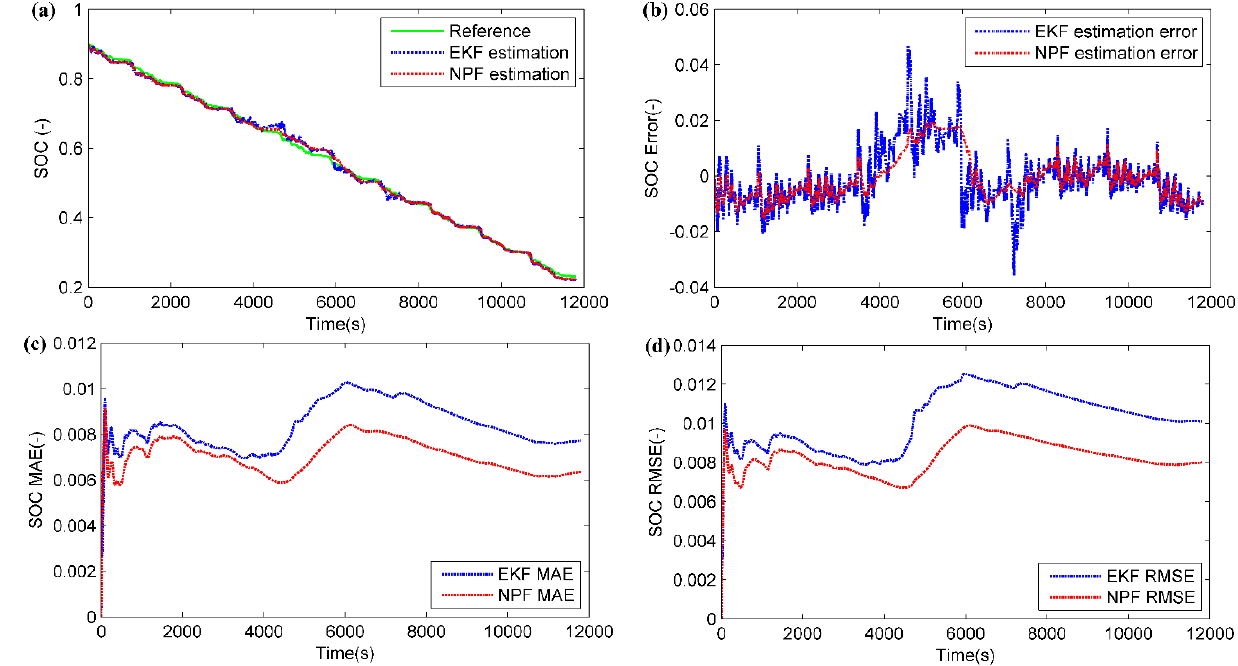
Figure 14. Comparison results of SOC estimation for LCO battery cell with accurate initial SOC: ( a ) SOC estimation; ( b ) Error of SOC estimation; ( c ) MAE of SOC estimation; ( d ) RMSE of SOC estimation.